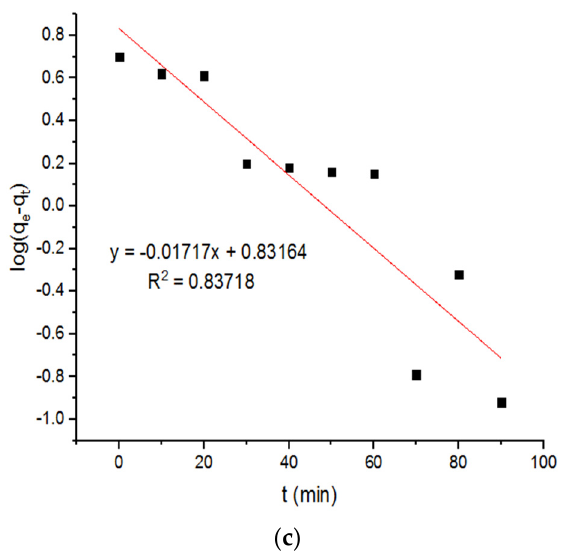
Figure 11. Pseudo-first-order plots for adsorption of Zn 2+ ions onto MgFe 2 O 4 -NH 2 nanoparticles pre-functionalization-calcined at ( a ) 500 °C, ( b ) 600 °C, and ( c ) 700 °C.